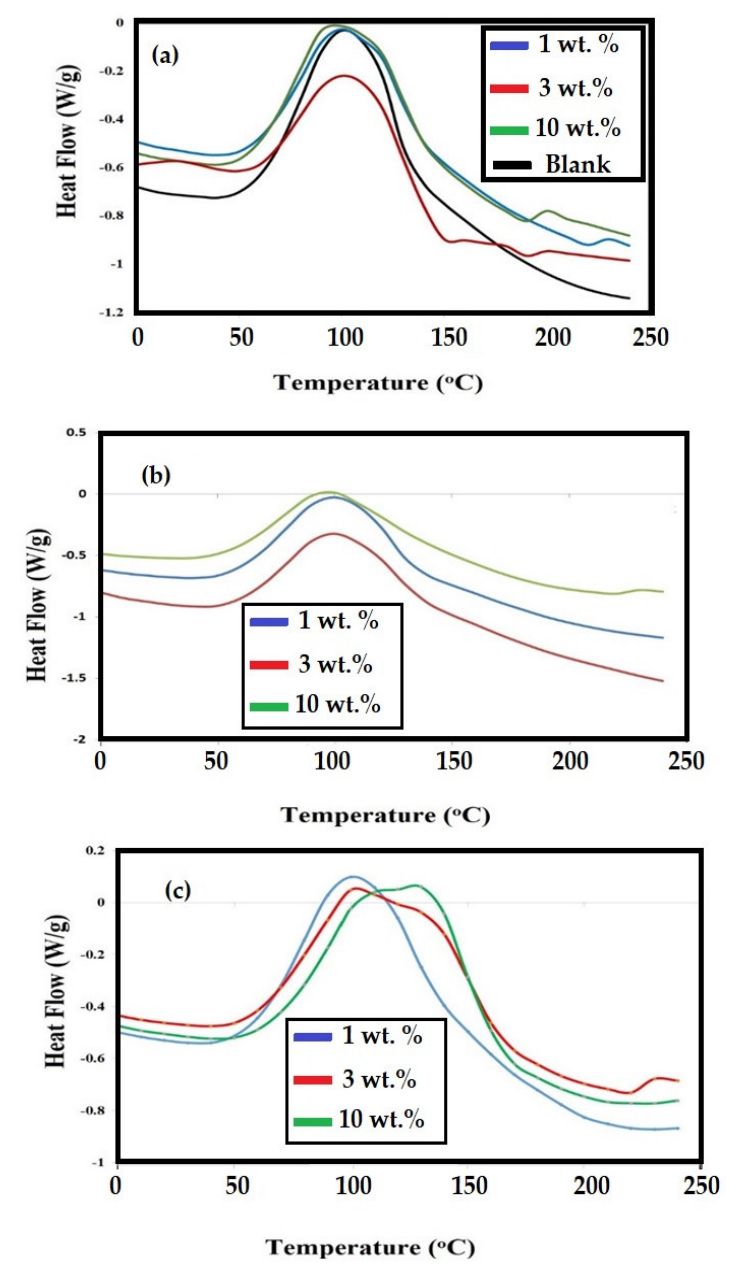
Figure 12. DSC thermograms of cured DGEB/PA in the presence of ( a ) ELNA-Fe 3 O 4 , ( b ) ELNA- TiO 2 and ( c ) EOA-Ag